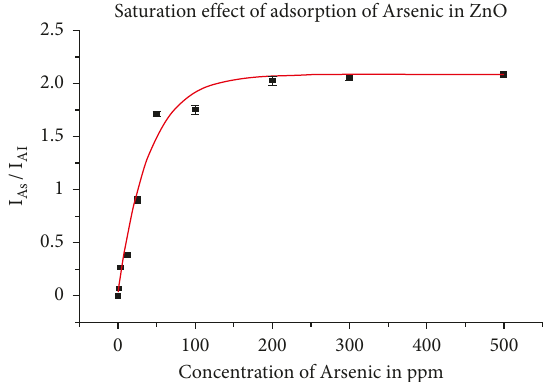
Figure 5: Saturation effect of calibration curve for adsorption of arsenic in zinc oxide adsorbent (adapted from